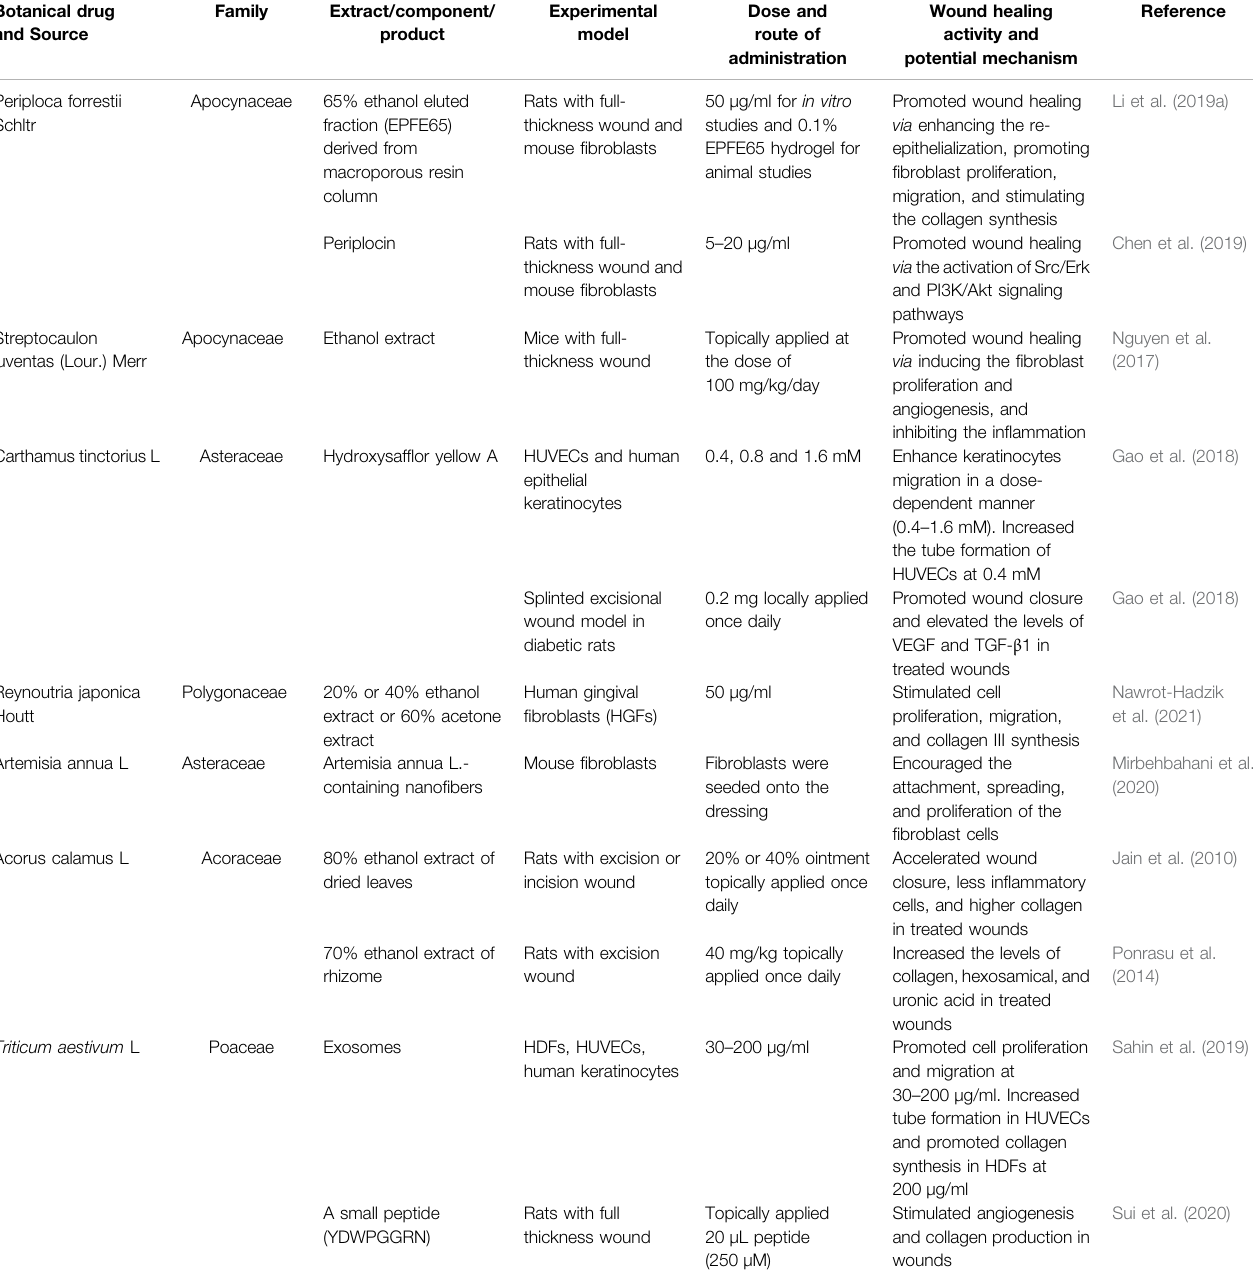
TABLE 1 | ( Continued ) Chinese botanical drugs and their wound healing